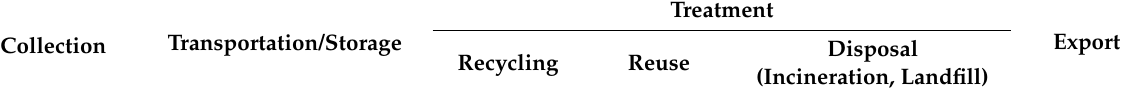
Table 5. Supply chain phase analyzed through MCDM